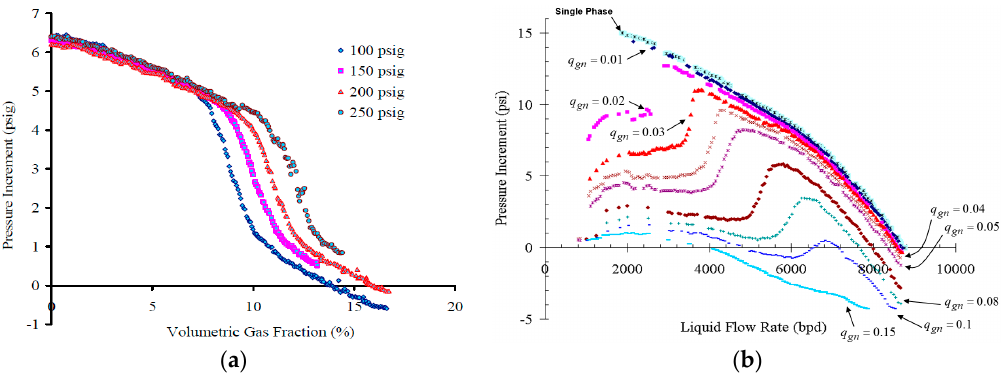
Figure 5. ESP two-phase pressure increment [40]. ( a ) Surging test; ( b ) mapping test.